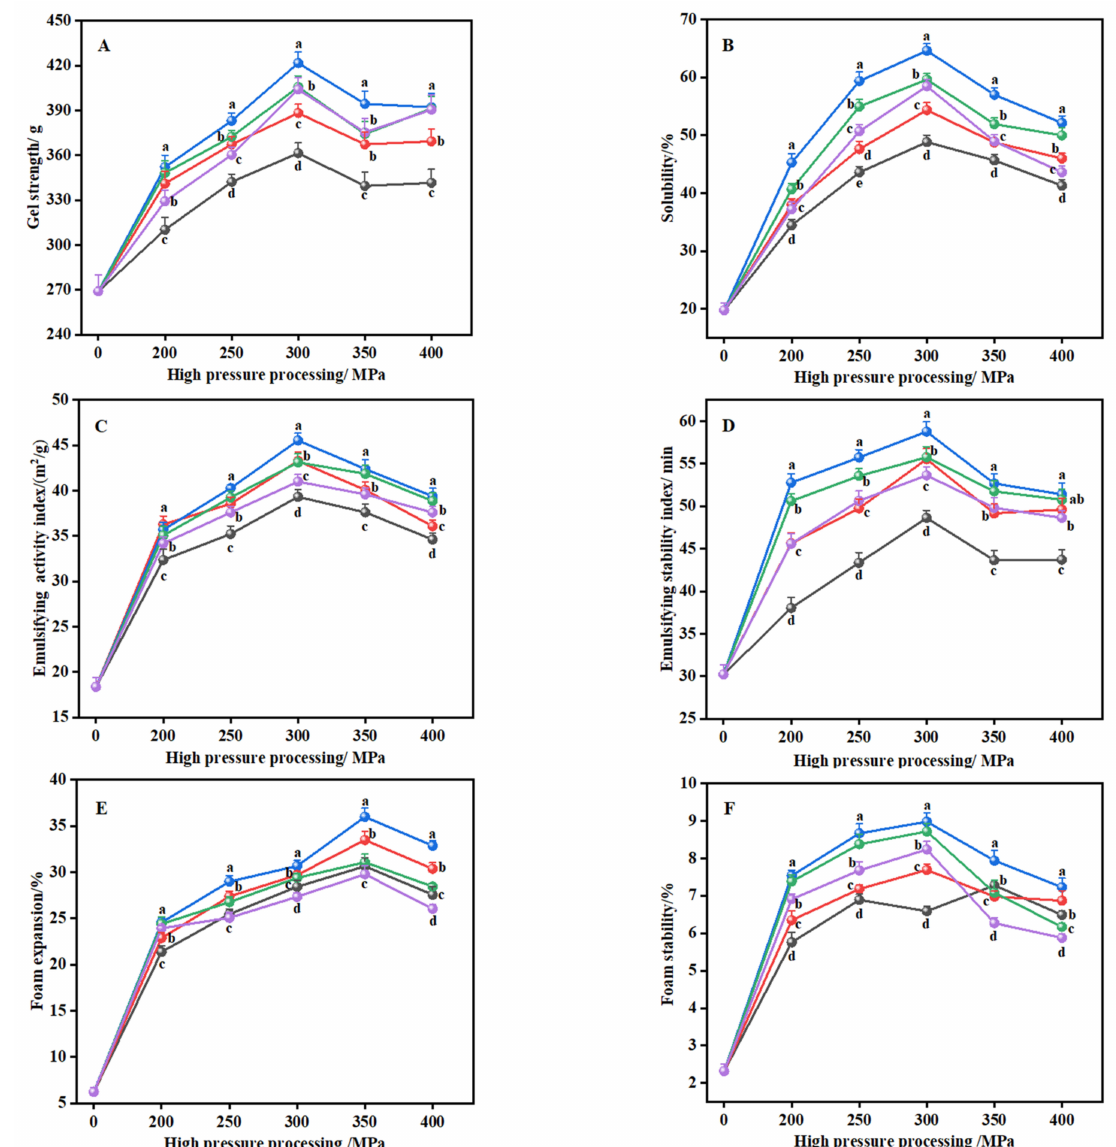
Figure 1. The effect of high hydrostatic pressure treatment on the gel strength ( A ), solubility ( B ), emulsification ( C , D ), and foaming ( E , F ) of cowhide collagen. The lowercase letters (a–e) indicate that different high-pressure durations have significant differences among the same pressure.